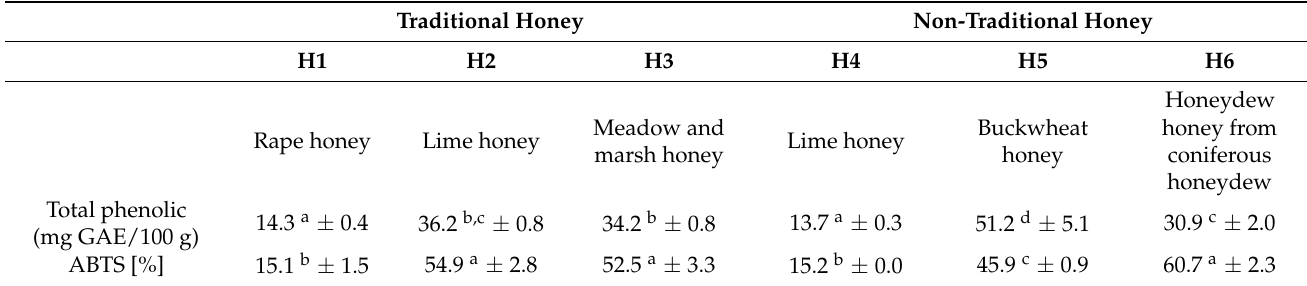
Table 3. Antioxidant properties of honeys and the total content of phenolic compounds determined in analyzed samples. Traditional Honey Non-Traditional Honey H1 H2 H3 H4 H5 H6 Honeydew honey from Buckwheat Meadow and Lime honey Lime honey coniferous honey marsh honey